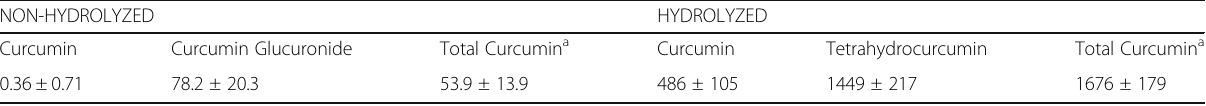
Table 1 AUC 0-6h ± SEM (ng*h/mL) for human plasma samples from 8 subjects that were assayed with and without enzymatic hydrolysis